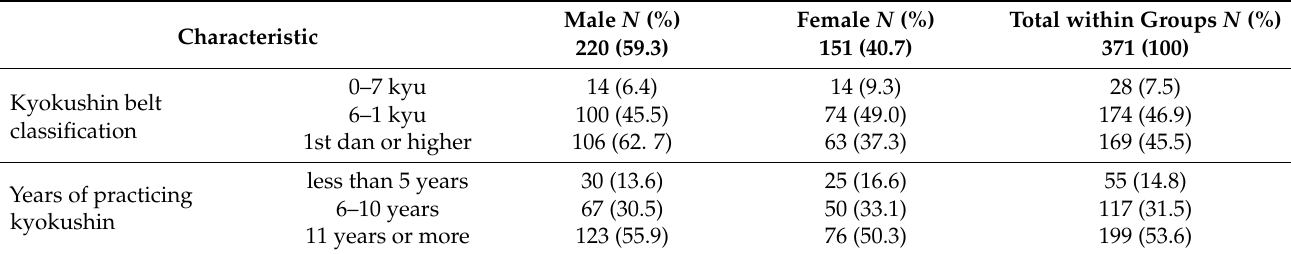
Table 1. Characteristics of